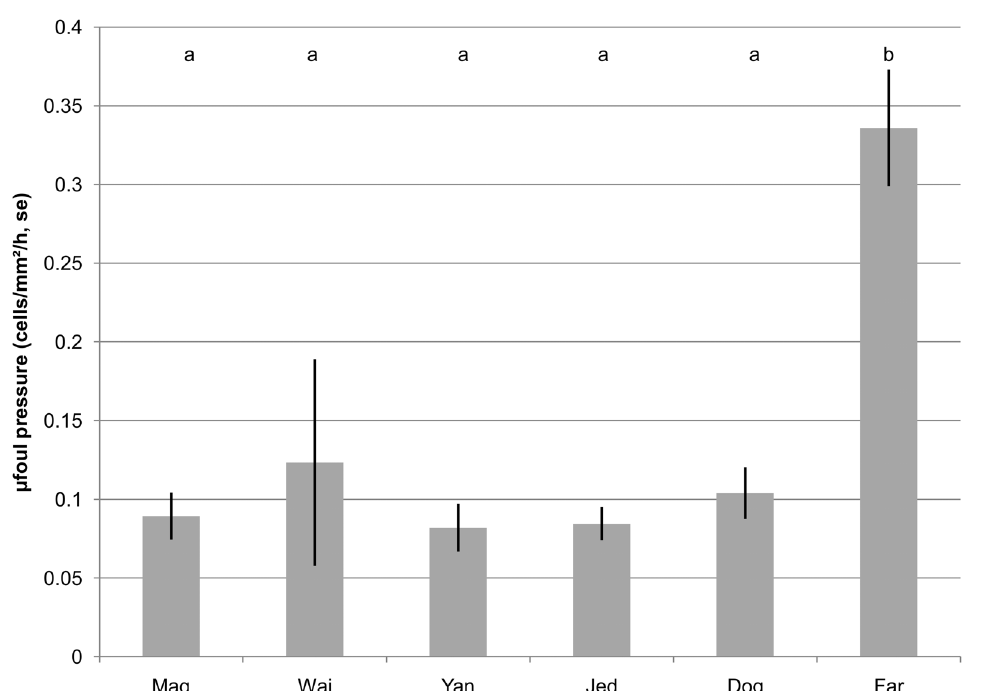
Fig. 3. Shifts in microfouling pressure (as settled cells per hour and mm 2 , ¡ SE) along the Saudi Red Sea coast from north (Maq) to south (Far). All sites sharing a letter in the top of the graph do not differ significantly (see Table 2).